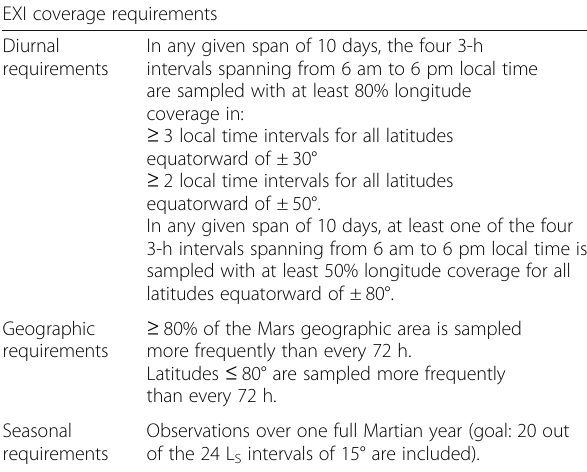
Table 3 Mission requirements for the spatial and temporal coverage of the EXI instrument subdivided into the diurnal, geographic, and seasonal parts. Adapted from AlShamsi et al. (2017)